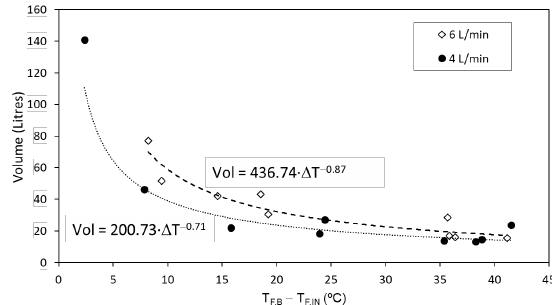
Figure 5. Experimental correlations for the mixed volume of hot water inside the tank due to water